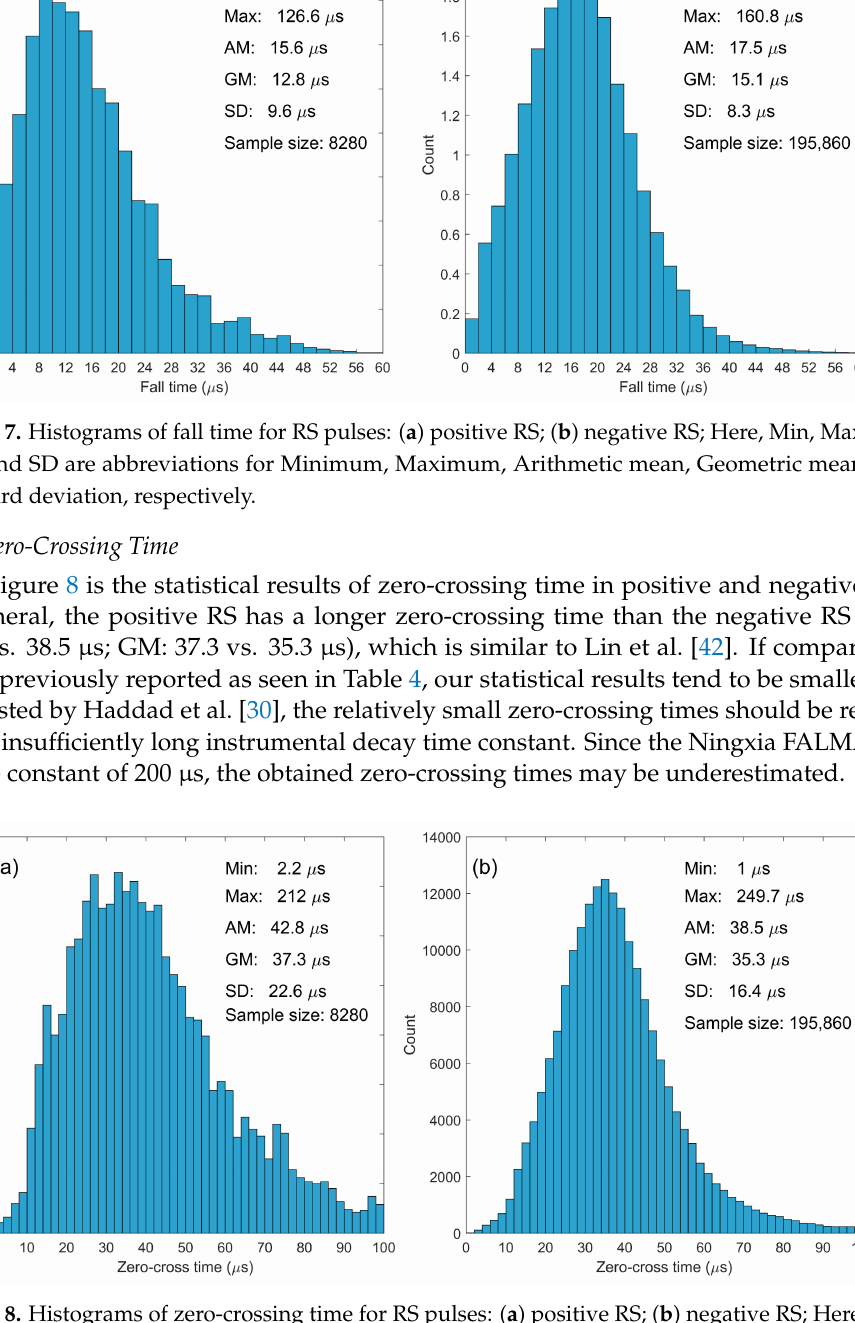
Figure 8. Histograms of zero-crossing time for RS pulses: ( a ) positive RS; ( b ) negative RS; Here, Min, Max, AM, GM, and SD are abbreviations for Minimum, Maximum, Arithmetic mean, Geometric mean, and Standard deviation, respectively. Table 4. Comparison of zero-crossing time among different studies.